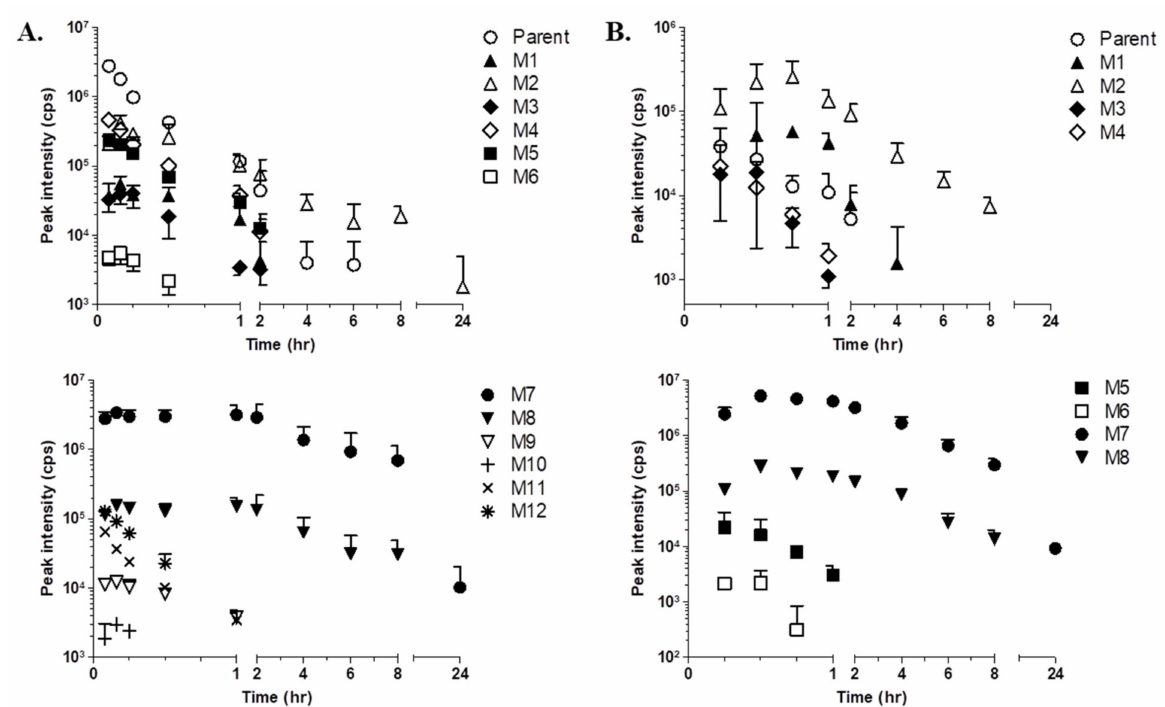
Figure 4. Peak area–time profiles for LW6 and its metabolites after intravenous ( A ) and oral ( B ) administration in mice. A single dose of LW6 was administered intravenously (( A ); 5 mg/kg; n = 3) or orally (( B ); 5 mg/kg; n = 3), and the plasma concentrations of LW6 and its metabolites were measured for 24 h post-dosing. Each point represents the mean ± S.D. (n =